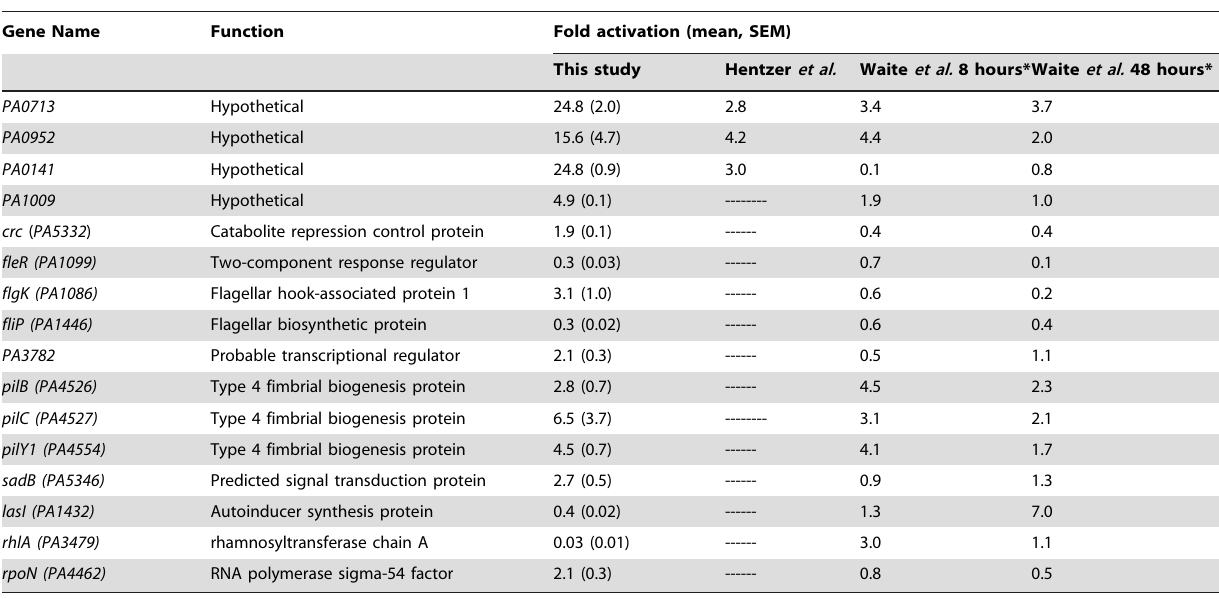
Table 2. Biofilm genes differentially expressed in P. aeruginosa murine GI colonization.